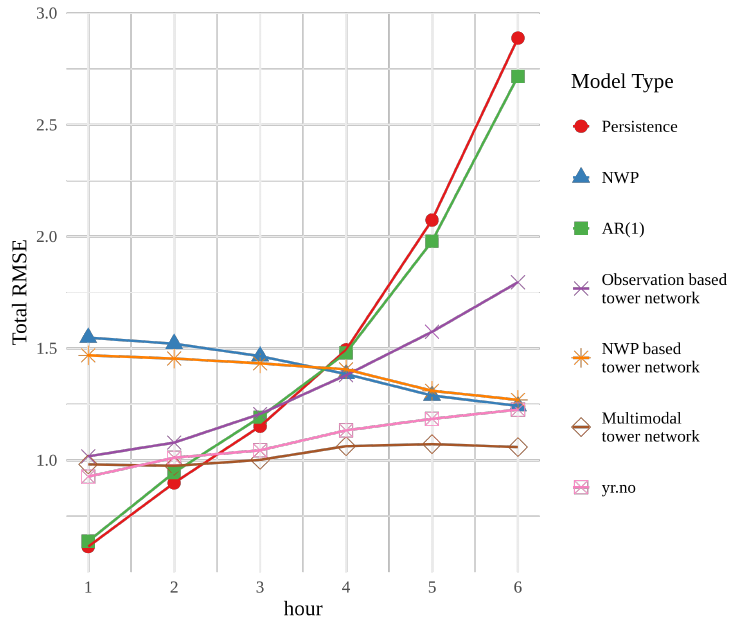
Figure 4. Root mean squared error of the tested models and meteorological baselines averaged over the spatial